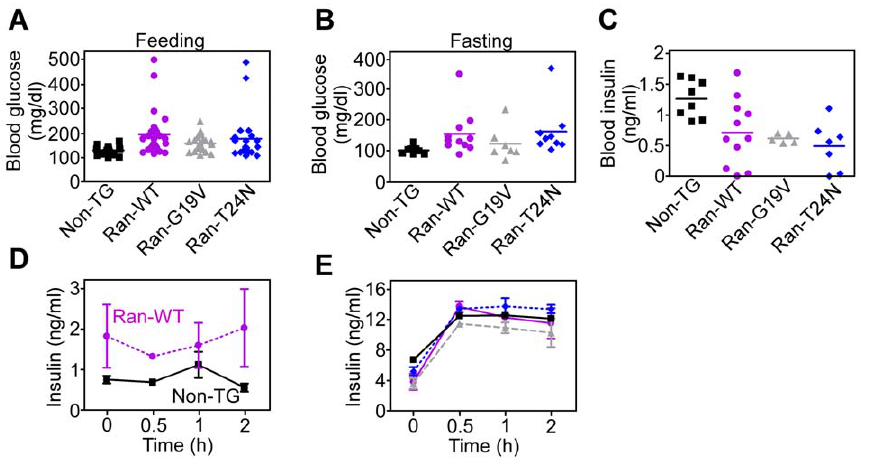
Figure 2. Transgenic expression of Ran impairs glucose metabolism. A and B , The indicated PCR-confirmed transgenic mice were analyzed for blood glucose content at 2 mo of age under ad libitum feeding ( A ) or fasting ( B ) conditions. Non-TG, non-transgenic mice. Glucose concentrations (mg/dl) in each group in A (number of mice in parentheses), and statistical analyses (unpaired t test) are as follows: Non-TG (n=24), 125 6 2; Ran-WT (n=26), 189.4 6 17.8, p=0.013; Ran-G19V (n=24), 153.7 6 6.5, p=0.003; Ran-T24N (n=21), 172.4 6 21.1, p=0.02. Statistical data re-analysis of the groups in A using ANOVA and post-hoc multiple tests with Bonferroni procedure was as follows: Ran-WT, p , 0.0001; Ran-G19V, 0.017; Ran-T24N, p=0.029. C , The indicated non-TG or Ran transgenic mice were analyzed for blood insulin concentrations. Insulin levels (ng/ml) in each group (number of mice in parentheses), and statistical analyses (unpaired t test) are as follows: Non-TG (n=8), 1.26 6 0.1; Ran-WT (n=11), 0.7 6 0.16, p=0.019; Ran-G19V (n=5), 0.61 6 0.03, p=0.0008; Ran-T24N (n=7), 0.49 6 0.14, p=0.0009. Statistical data re-analysis using ANOVA and post-hoc multiple tests with Bonferroni procedure was as follows: Ran-WT, p=0.023; Ran-G19V, p=0.031; Ran-T24N, p=0.004. One outlier mouse in the Ran- G19V group with aberrantly high insulin level (2.35 ng/ml) was excluded from the analysis. For panels A–C , each point corresponds to an individual mouse. D , Islets (20/well) isolated from non-TG or Ran-WT transgenic mice were incubated with 5 mM D-glucose, and analyzed for insulin release in the supernatant at the indicated time intervals. Mean 6 SD of replicates. E , Islets (20/well) isolated from non-TG ( black ) or Ran-WT ( purple ), Ran-G19V ( grey ) or Ran-T24N ( blue ) transgenic mice were incubated with 16.7 mM glucose, and analyzed for insulin release in the supernatant at the indicated time intervals. Mean 6 SD of replicates.